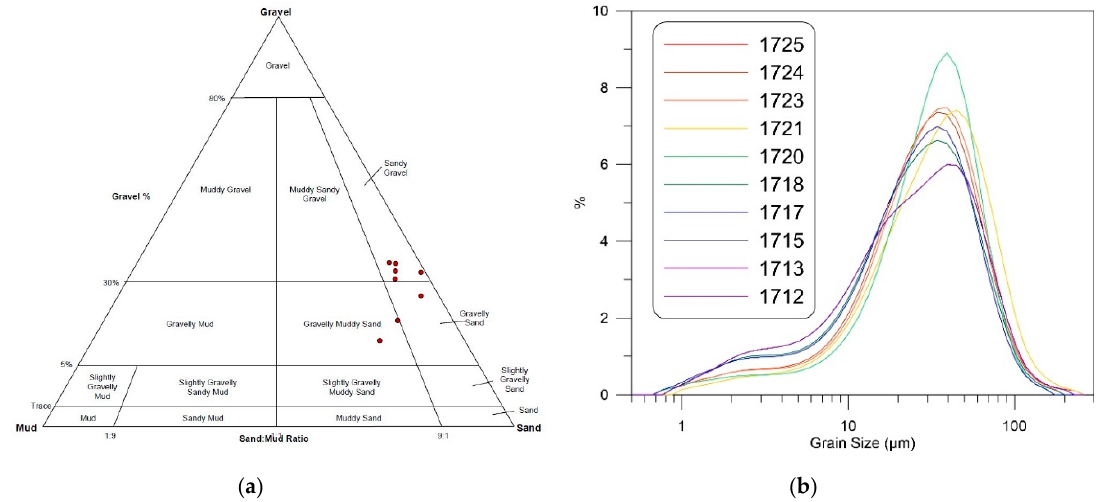
Figure 7. Grain size distributions of samples from the Lake Clover beach ridges. ( a ) Samples plotted on a ternary diagram of mud / sand / gravel. Nearly all samples classify as either sandy gravel or gravelly sand. Samples 1725 is finer, classifying as a gravelly muddy sand. ( b ) Results of grain size analysis with laser scattering of the fine ( < 63 µ m) fraction of the grain size samples. All samples are similar, with an overall mean of 31 µ m. Samples are designated by their corresponding lake elevation, as shown in Table 1. 45